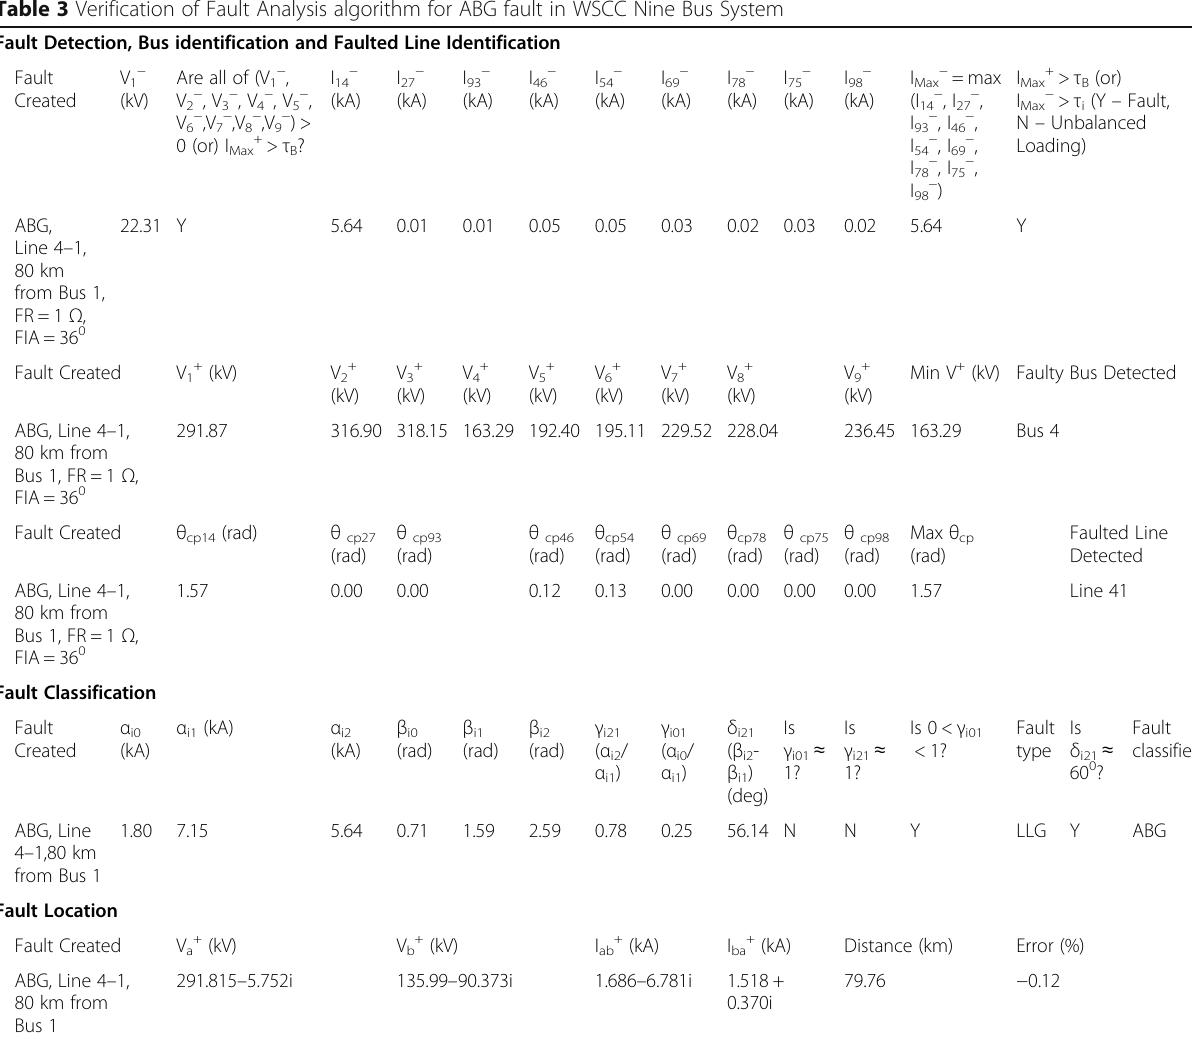
Table 3 Verification of Fault Analysis algorithm for ABG fault in WSCC Nine Bus System Fault Detection, Bus identification and Faulted Line